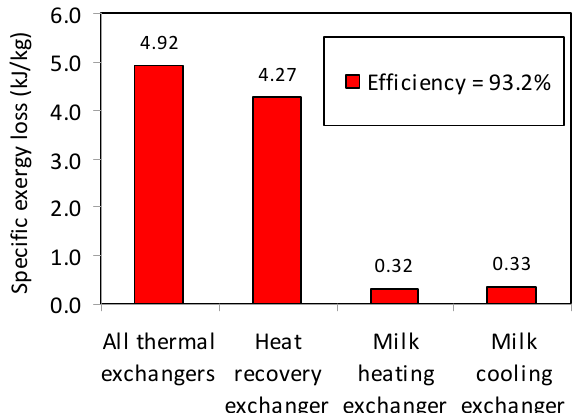
Figure 2. Exergetic losses in all thermal exchangers system and in each exchanger referred to the current Italian condition with actual e ffi ciency ε A = 93.2%.